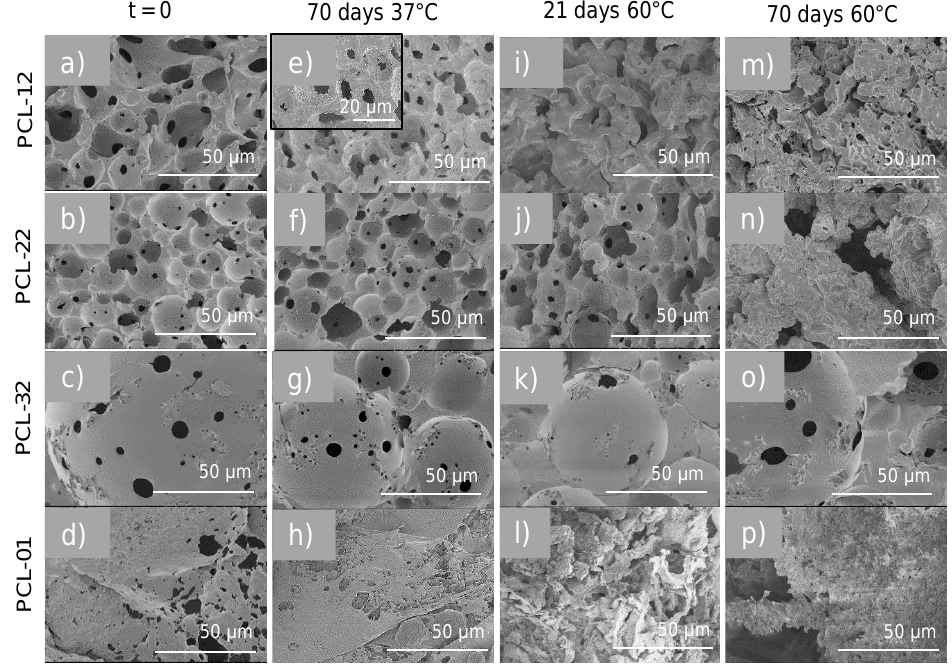
Figure 4. SEM micrographs of the surface of the degraded samples before degradation (t = 0) ( a – d ), after 70 days at 37 °C ( e – h ), 21 days at 60 °C ( i – l ) and 70 days at 60 °C ( m – p ).